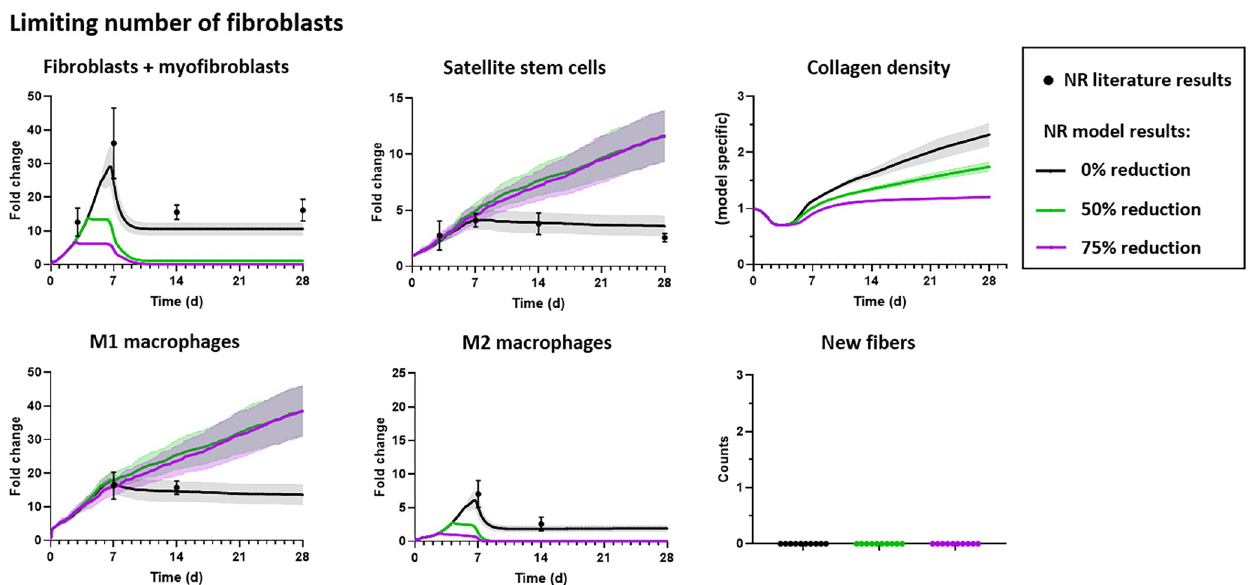
Fig 7. Limiting the number of fibroblasts in the no repair (NR) ABM reduced the number of fibroblasts and myofibroblasts following VML injury and altered the amount of fibrosis as indicated by collagen density. The number of fibroblasts was reduced to 50% and 75% of baseline levels. Outputs included fibroblast and myofibroblast fold changes, SSC fold changes, collagen density, macrophages fold changes, and numbers of new, regenerated fibers. Reducing the number of fibroblasts to 50% or 75% of baseline increased the number of SSCs and impaired the rate and extent of collagen accumulation in the defect. None of the perturbations to fibroblasts resulted in new muscle fibers filling the defect. Model results were reported as mean ± 95% confidence interval. Aguilar et al. 2018 experimental data of fibroblasts and SSCs reported as median ± standard deviation, and Garg et al. 2014 experimental data of M1 and M2 macrophages reported as mean ± standard error mean [9,23].